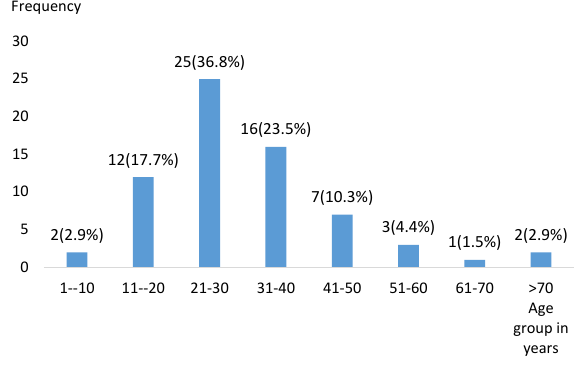
Figure 1. Age distribution of